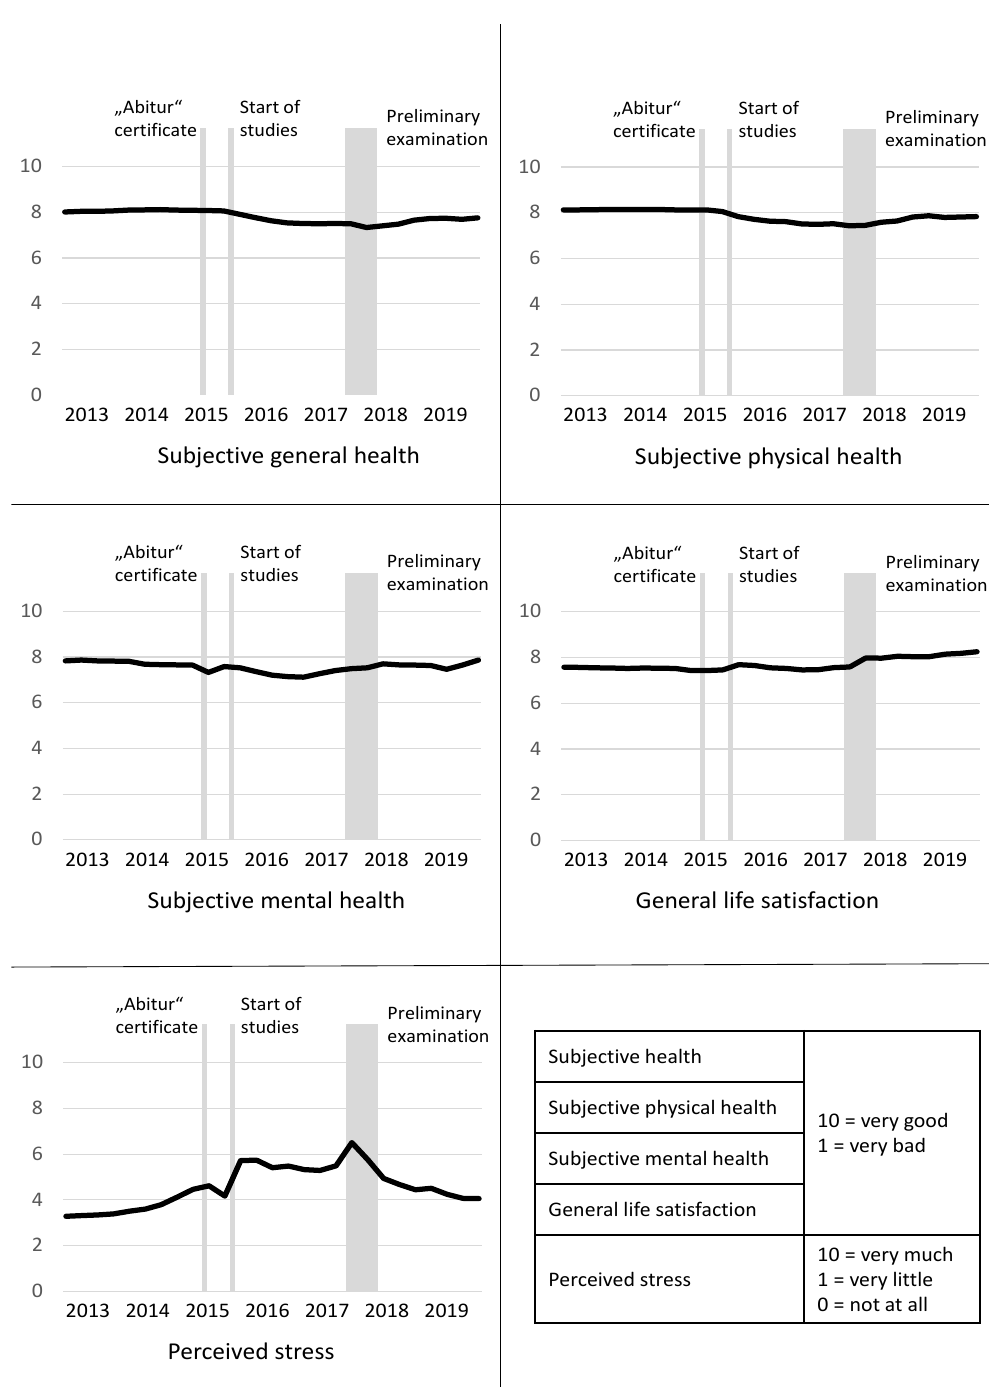
Figure 2. Results of the mapping grid (mean of 30 medical students).